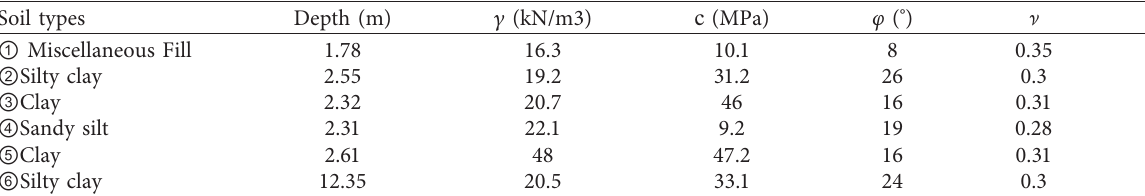
Figure 2: Sectional drawing of underground excavation (units: mm). Table 1: Soil parameters.